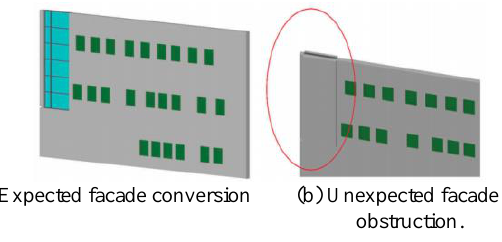
Figure 1. Data inconsistency after conversation process.